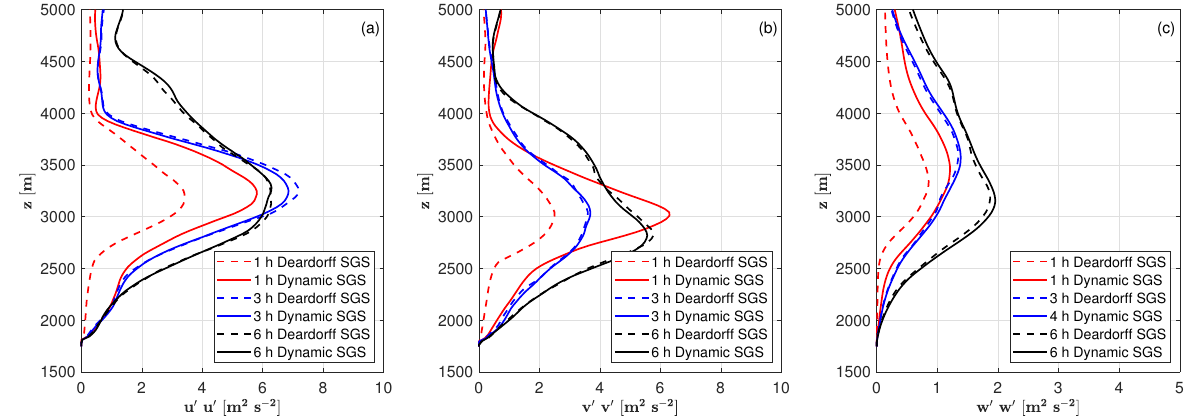
Figure 10. Horizontal mean variances of ( a ) wind component u , ( b ) wind component v and ( c ) wind component w at the whole domain in time after the start of the simulation at 06:00 UTC. The dashed curves indicate the simulated values by using Deardorff SGS model. The continuous curves present the simulated values by using the dynamic SGS